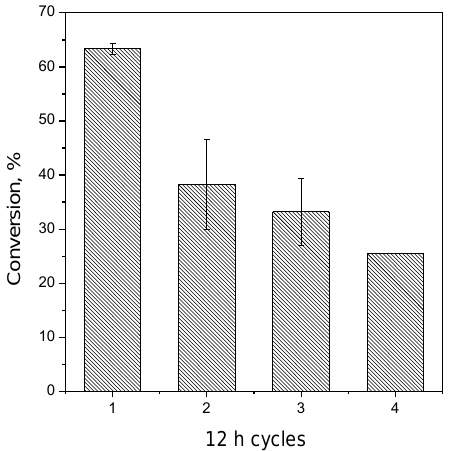
Figure 5. Reuse assays converting starch to maltose at 40 °C, pH 7.0 in a vortex flow reactor stirred at 900 rpm, using cassava bagasse starch solution (8.2 g/L) and CLEA-β-PS-12 (36.0 U/L).